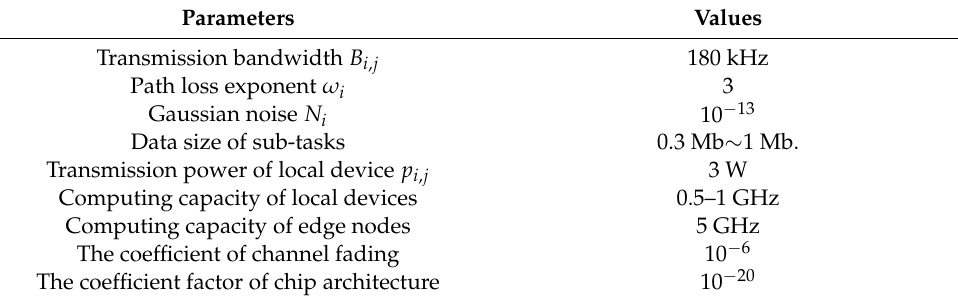
Table 2. Setting of parameters.